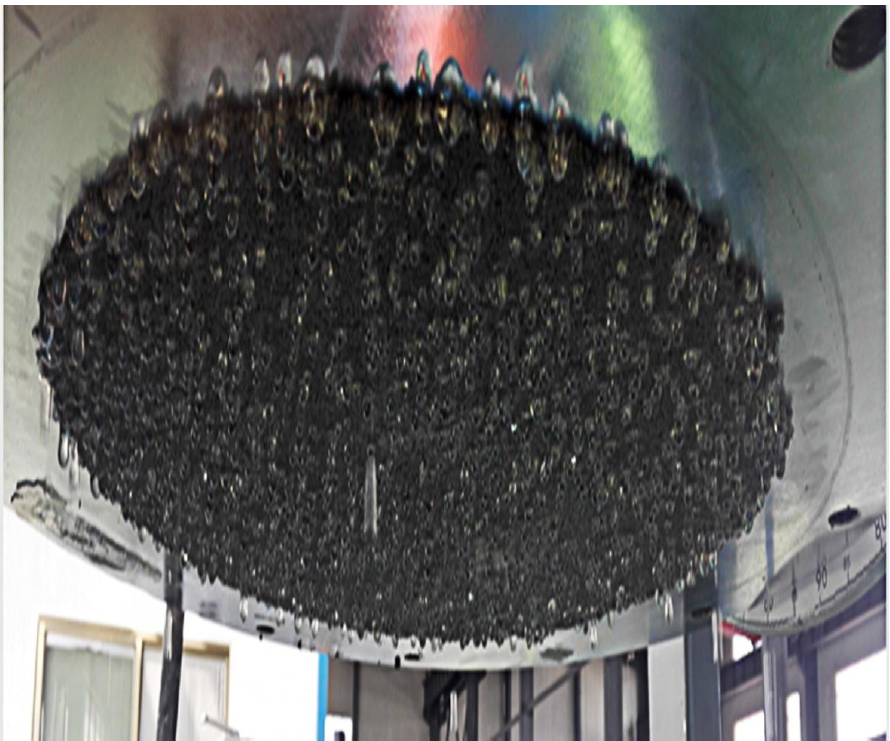
Figure 5. Water seepage stage in the vault cavity.